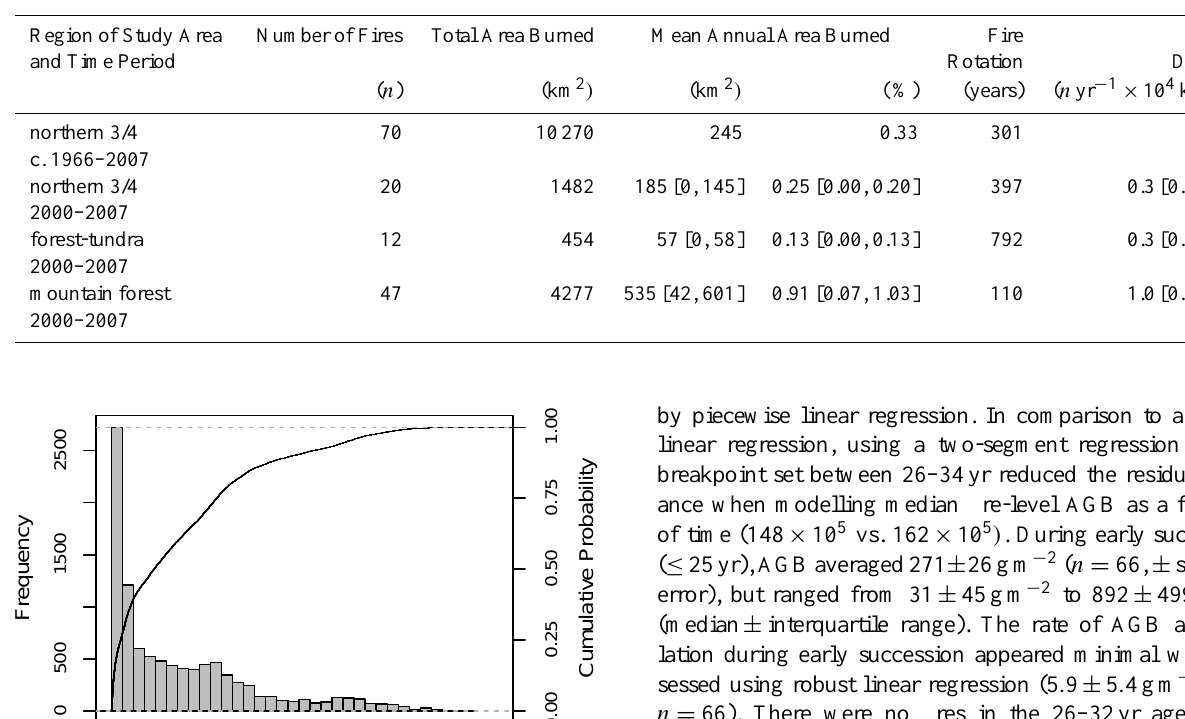
Table 4. Summary of fire activity across 100000km 2 of the Kolyma River watershed in far northeastern Siberia. Annual area burned and fire density are annual means, with 25th and 75th percentiles to show skewness. Region of Study Area Number of Fires Total Area Burned Mean Annual Area Burned Fire Fire and Time Period Rotation Density